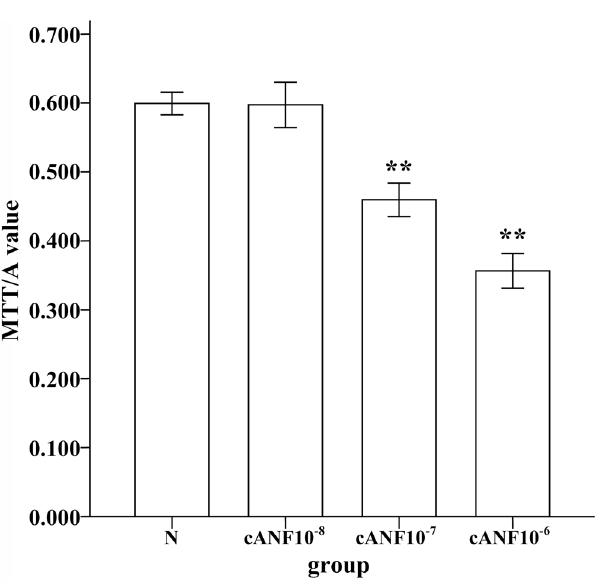
Fig 6. Effects of cANF on A value of MTT of rat GSMCs. cANF The average value was 0.599 ± 0.016 in control group, 0.597 ± 0.033 in 10 − 8 mol/L group, 0.459 ± 0.024 in 10 − 7 mol/L group and 0.356 ± 0.025 in 10 − 6 mol/L